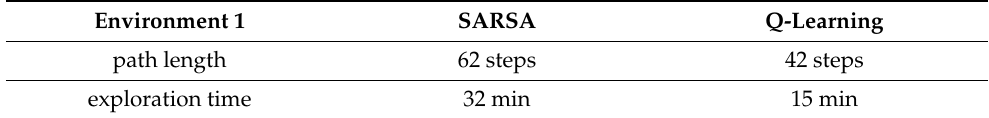
Figure 26. Training results of Q-Learning and SARSA in Environment 1, ( a ) is Q-Learning training result, ( b ) is SARSA training result.